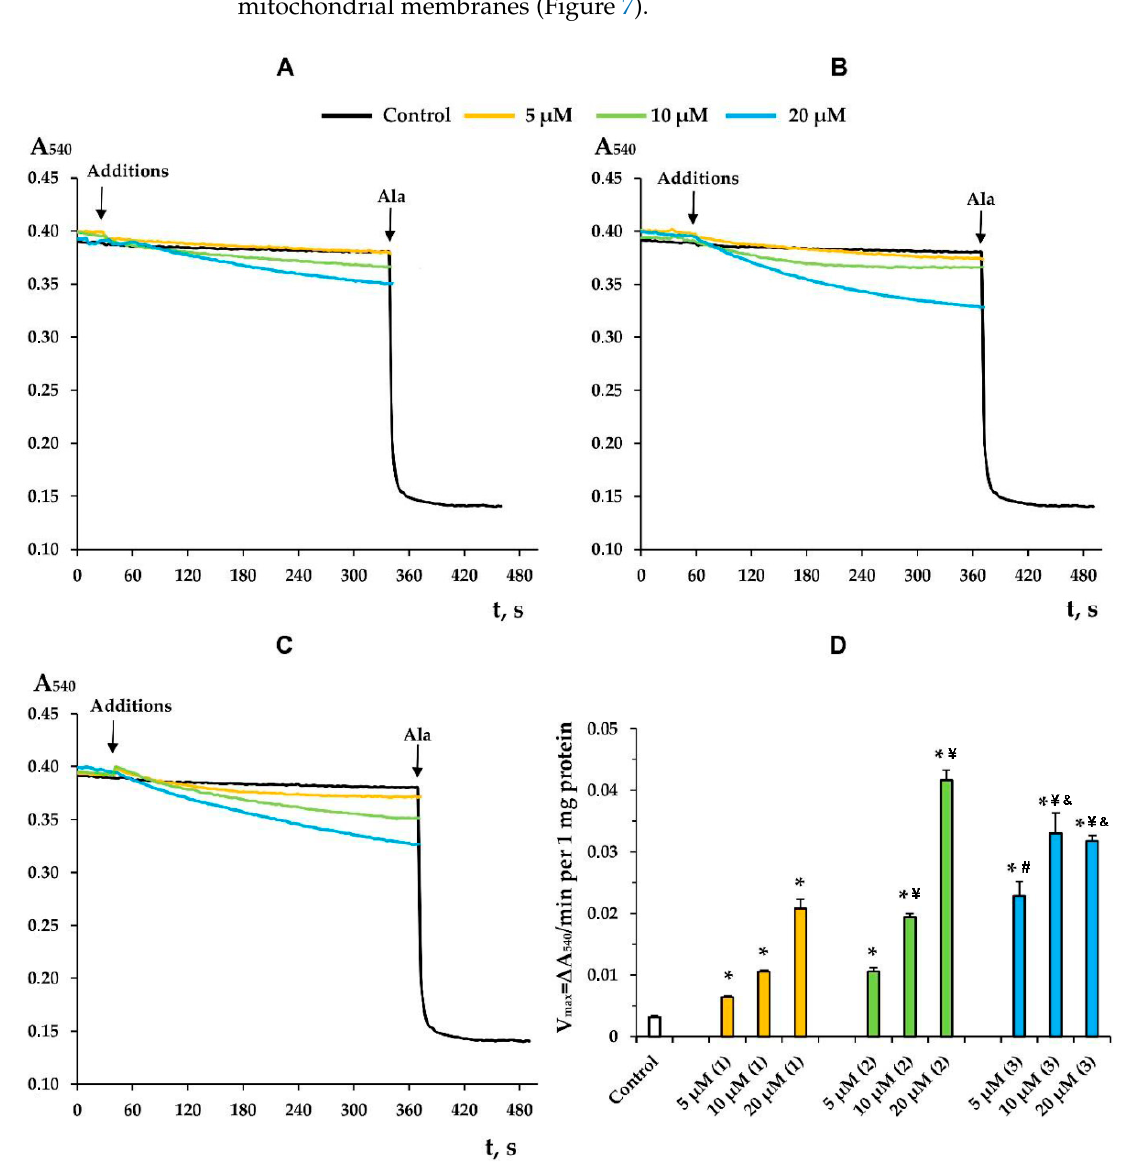
Figure 7. The swelling of liver mitochondria induced by modified levopimaric acid diene adducts: compound 1 ( A ), compound 2 ( B ) and compound 3 ( C ). Control curves obtained in the absence of additions. Alamethicin (Ala) (5 μ g/mL) was added to induce maximal swelling. The picture shows typical curves recorded with the same sample during the same experiment. Similar results were observed in three other independent experiments. Panel D shows the rates of swelling induced by various concentrations of tested agents. The results are presented as means ± SEM ( n = 4). * p < 0.05 (versus control), # p < 0.05 (versus 5 μ M of compounds 1 and 2 ), ¥ p < 0.05 (versus corresponding concentration of compound 1 ), & p < 0.05 (versus corresponding concentration of compound 2 ).